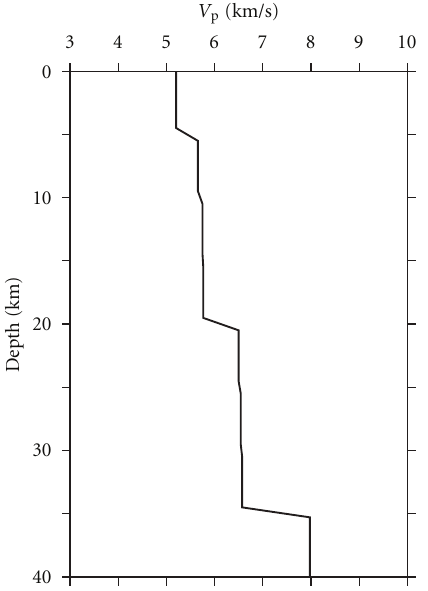
Figure 4: The starting 1D model used for the tomoDD in this study.